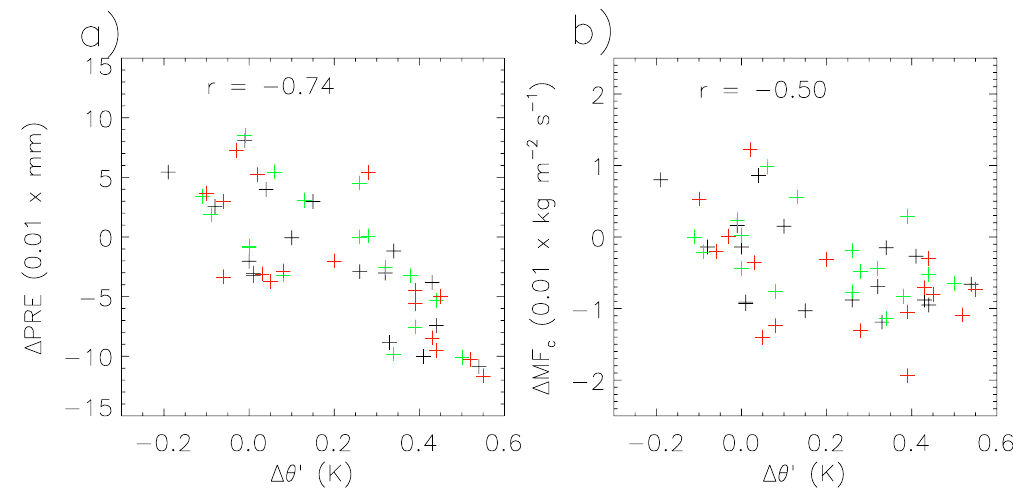
Fig. 9. Scatterplots of the changes between polluted and pristine conditions (POLL minus PRIS) in (a) domain-mean accumulated surface precipitation ( 1 PRE) versus low-level potential temperature averaged within the cold pool ( 1θ ’) and (b) domain-mean convective mass flux at a height of 8.25km ( 1 MF c ) versus 1θ ’, for all configurations shown in Table 2. 1 MF c and 1θ ’ are averaged from t = 90 to 120min; 1 PRE is the difference at t = 120min. Results with maximum θ 0 of 2.5, 3, and 3.5K for the thermal used to initiate convection are shown in red, black, and green,